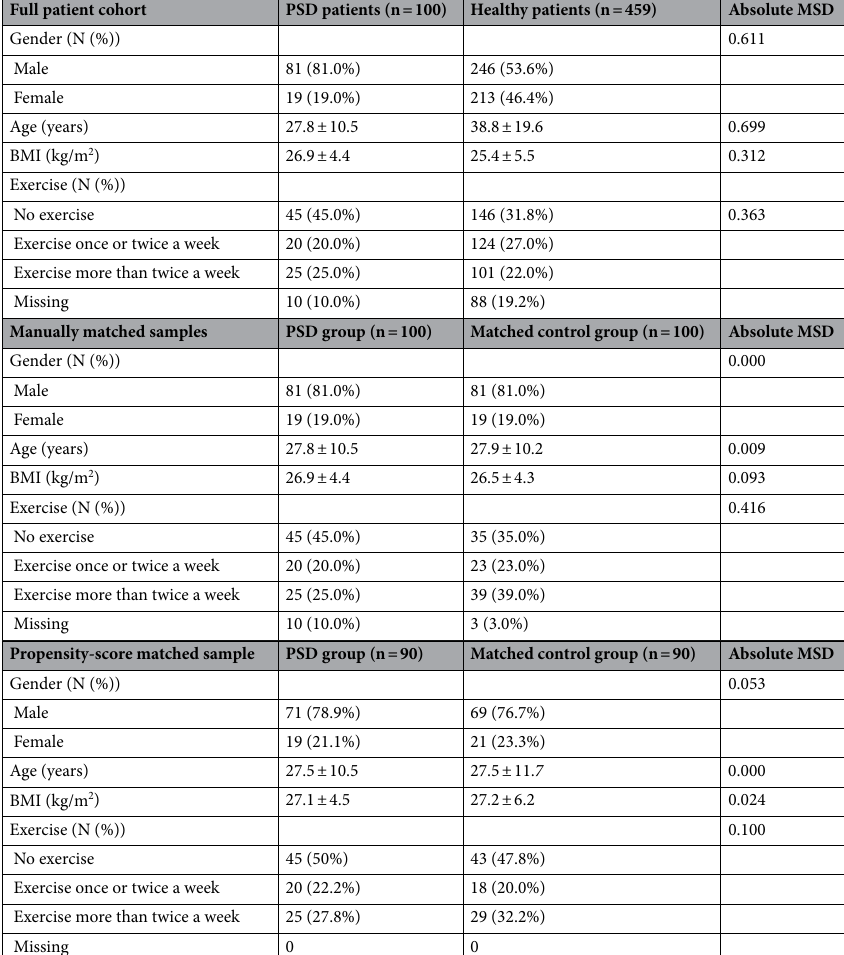
Table 2. Distribution of baseline characteristics before and after matching.